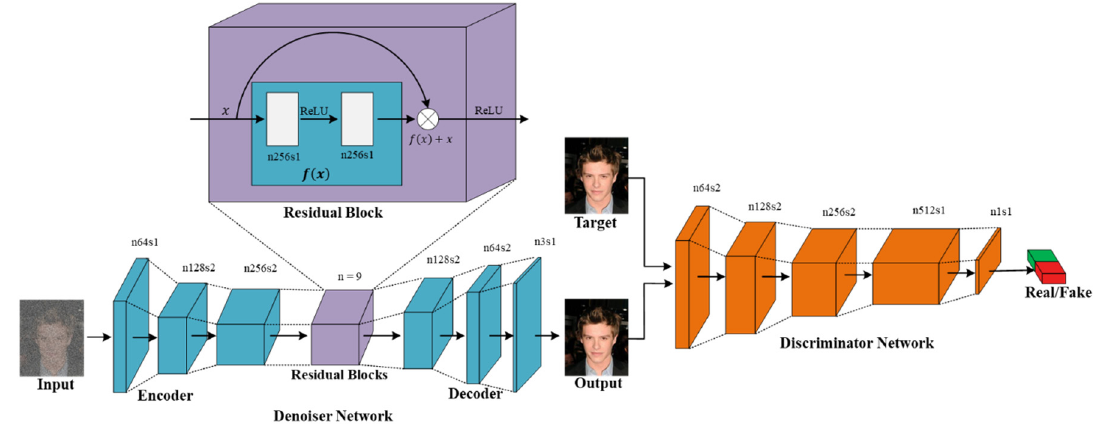
Figure 2. AGDN framework. AGDN consists of the denoiser, V , and the discriminator, D . The denoiser, V , aims to construct noise-free images from the given noisy images. It consists of the encoder-decoder configuration with three down-sampling convolution stride-1 and stride-2 layers, nine residual blocks, two up-sampling transposed convolution layers of stride-2, and one convolutional layer of stride-1. The discriminator, D , includes the convolutional batch-normalization leaky ReLU layers, and the output of 𝐷 is utilized to differentiate the constructed images from the real images.